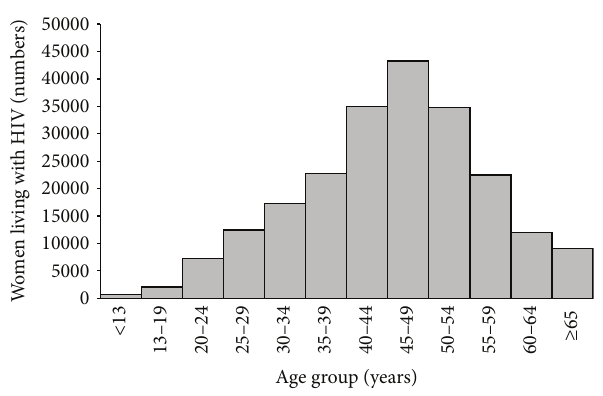
Figure 1: Estimated numbers of women living with HIV infection, 46 states, United States, 2011. Estimates were calculated based on data provided in [6].